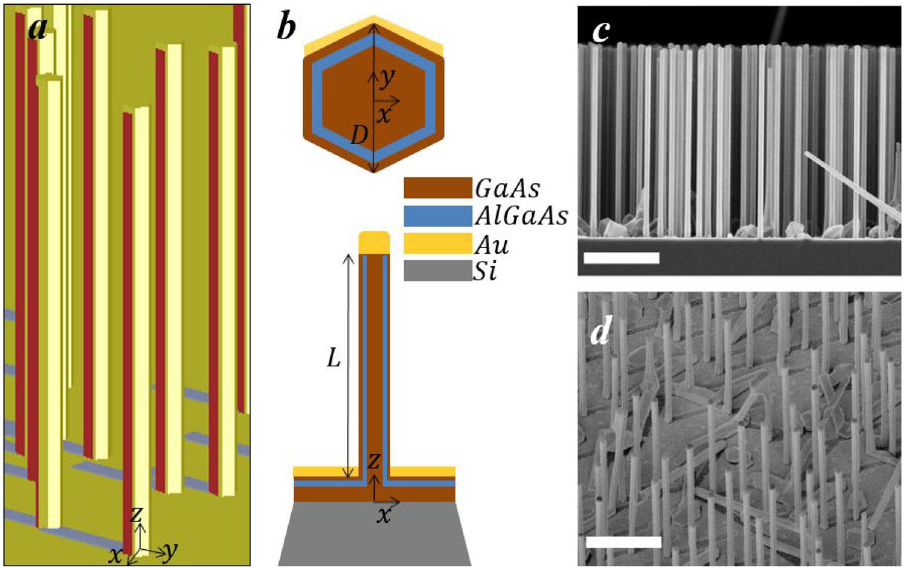
Figure 1. ( a ) 3D schematic of the NW ensemble. ( b ) Cross section of one NW in the xy and xz planes, with overall diameter D, and NW length L. ( c ) Side-view SEM image of Sample B0. ( d ) Tilted SEM image of 3D distribution of Sample B1. Scale bar equals 2